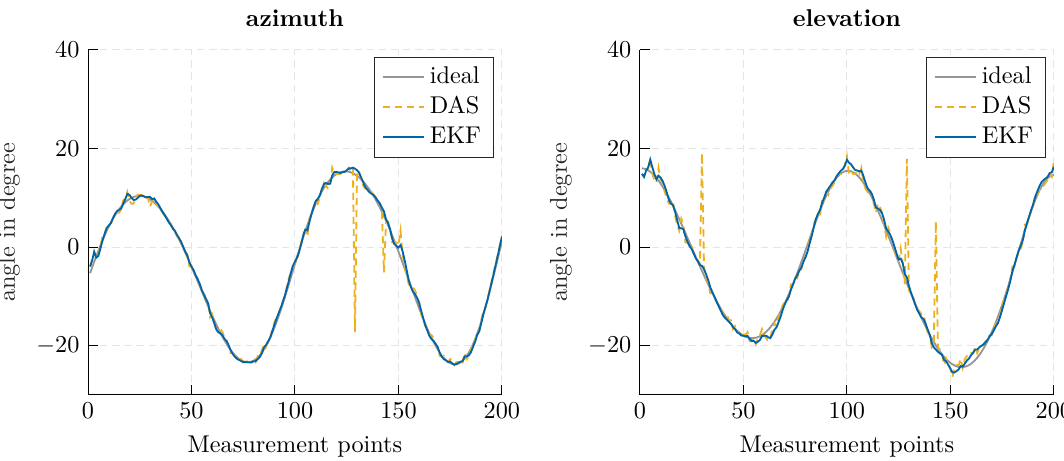
Figure 6. Azimuth ( left ) and elevation ( right ) angle for a classical delay-and-sum (DAS) beamformer (yellow, dashed) and EKF-based approach (blue, solid), in comparison to the ideal angle (gray, solid).